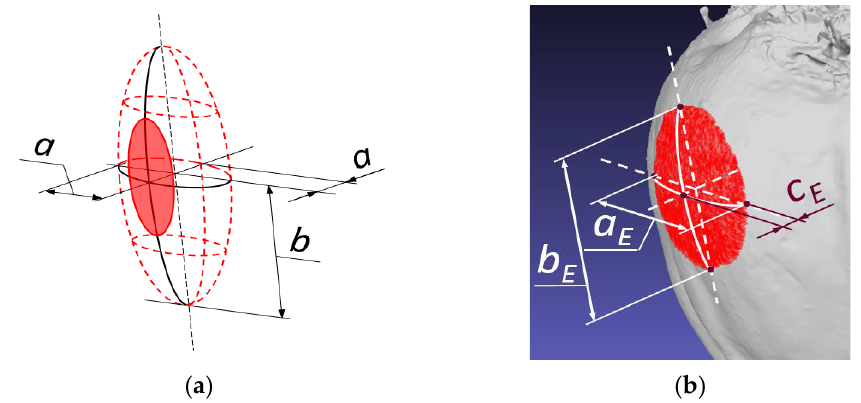
b —the large ellipsoid half-axis, mm.